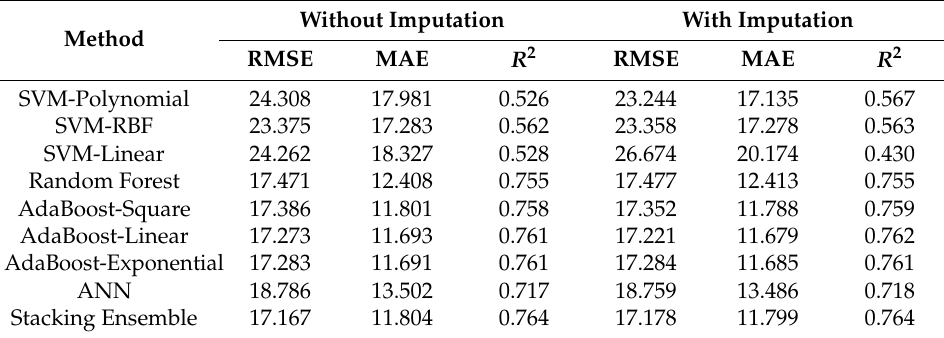
Table 5. Results of ML Algorithms for Zhongli F8-AQI Prediction.